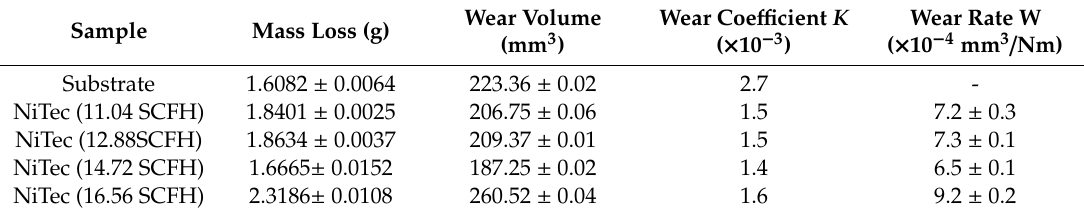
Table 6. Abrasive wear test parameters of NiTec